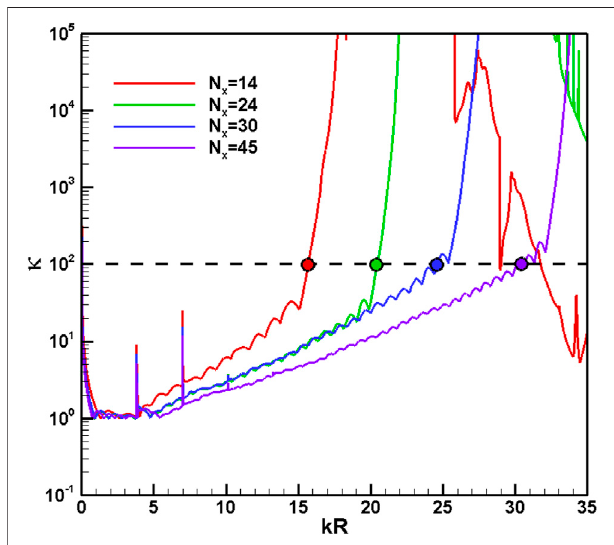
FIGURE 4 | Condition numbers at optimal spacing for the four axial arrays.